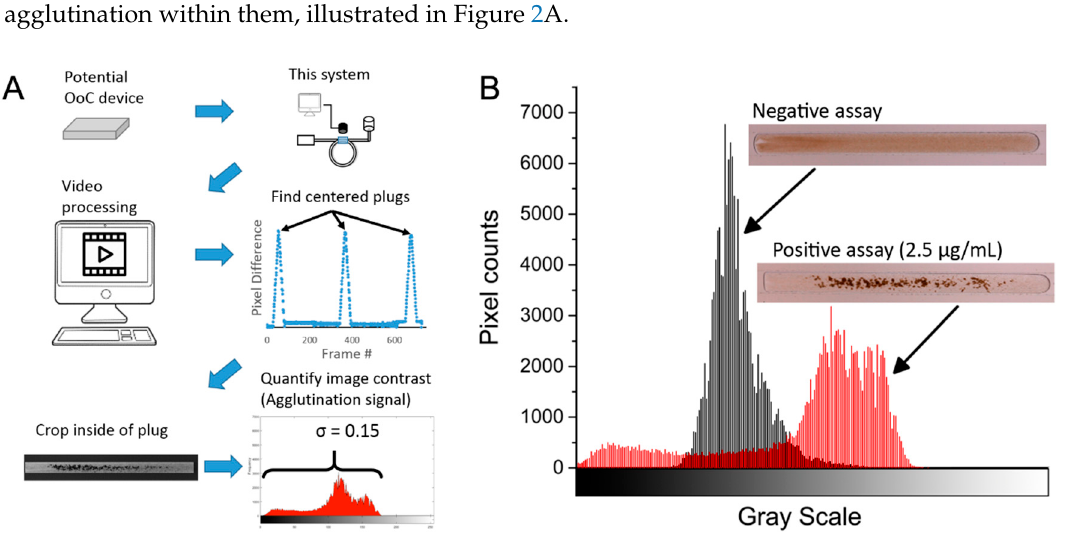
Figure 2. ( A ) Example of plug quantification and workflow. The image processing algorithm detects changes in the field of view of a video and identifies the frame containing a complete and centered image of a plug. A region of interest of the interior of the plug is cropped, and the standard deviation of its grayscale values is obtained. ( B ) Example histograms of a negative (microbeads + simple bovine serum albumin (BSA)) and a positive test (microbeads + biotinylated BSA, 2.5 µg/mL in the example shown). In a negative test, the uniform suspension of microbeads is seen as a low contrast region with a narrow grayscale distribution. Conversely, a positive test will have dark aggregates of microbeads, resulting in higher contrast and a wider histogram. OoC:Organ-on-Chip; σ : standard deviation.